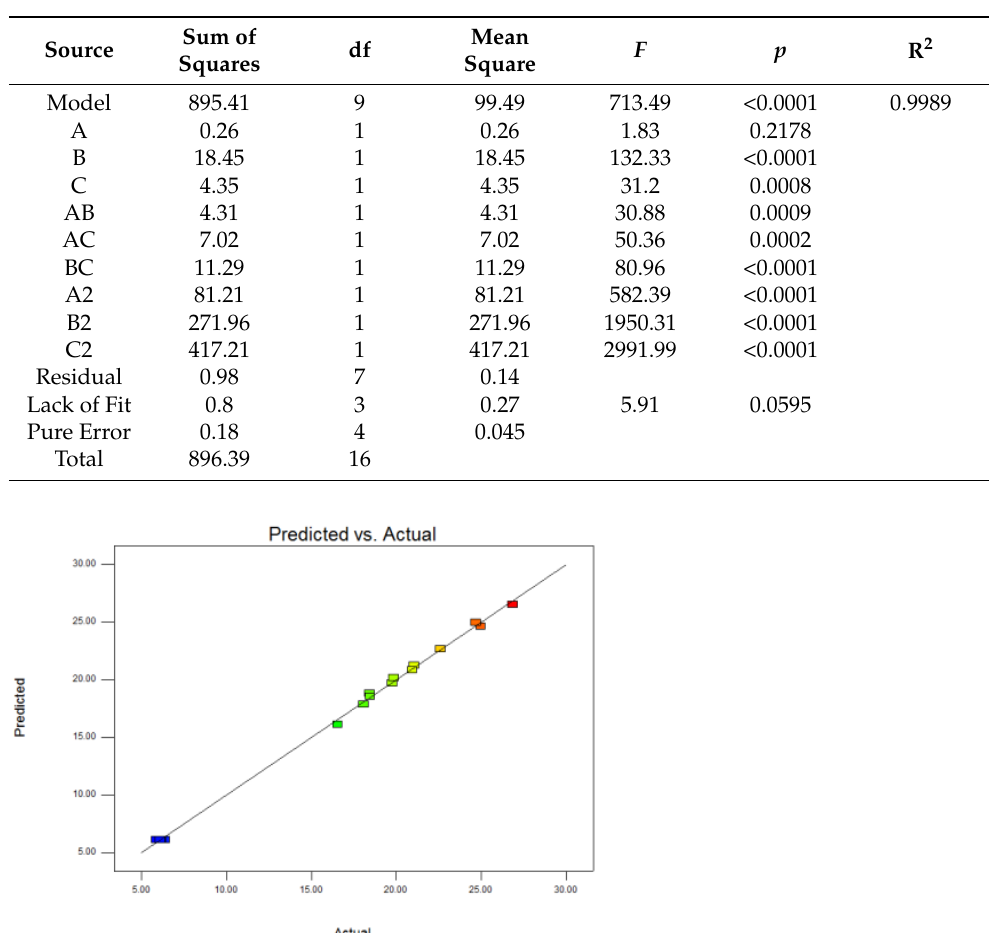
Table 5. Variance analysis of Fe 3+ regression model.